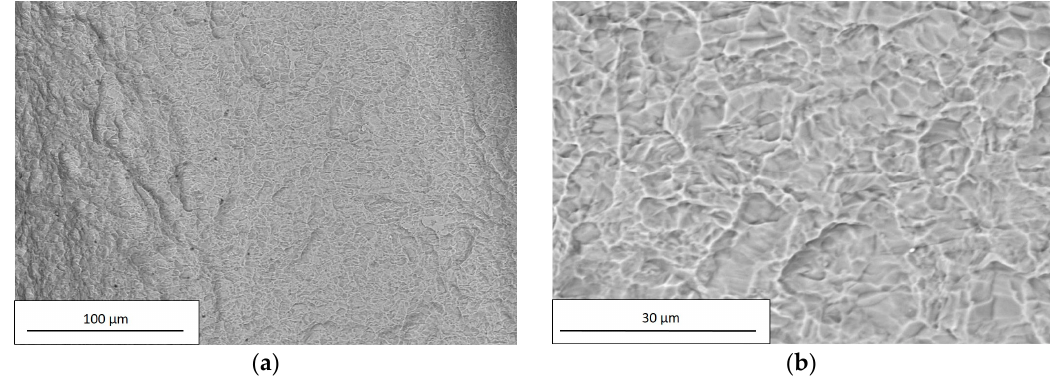
Figure 10. SEM observation of C, acquired using a Hitachi TM3000 with a magnification of ( a ) 250× and ( b ) 2500×.